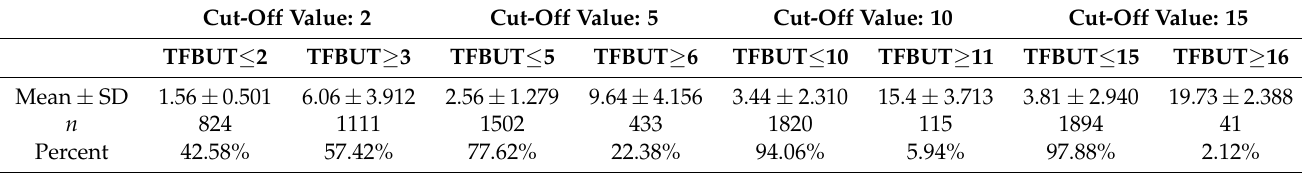
Table 3. Distribution of tear film break-up time (TFBUT) above and below each cut-off value. Cut-Off Value: